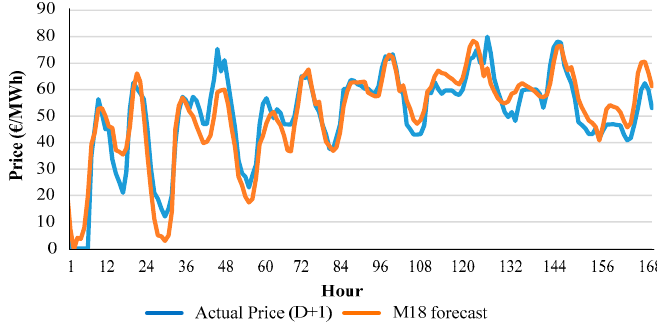
Figure 6. Actual price values and forecast values of model M18 for week 7 of year 2013.